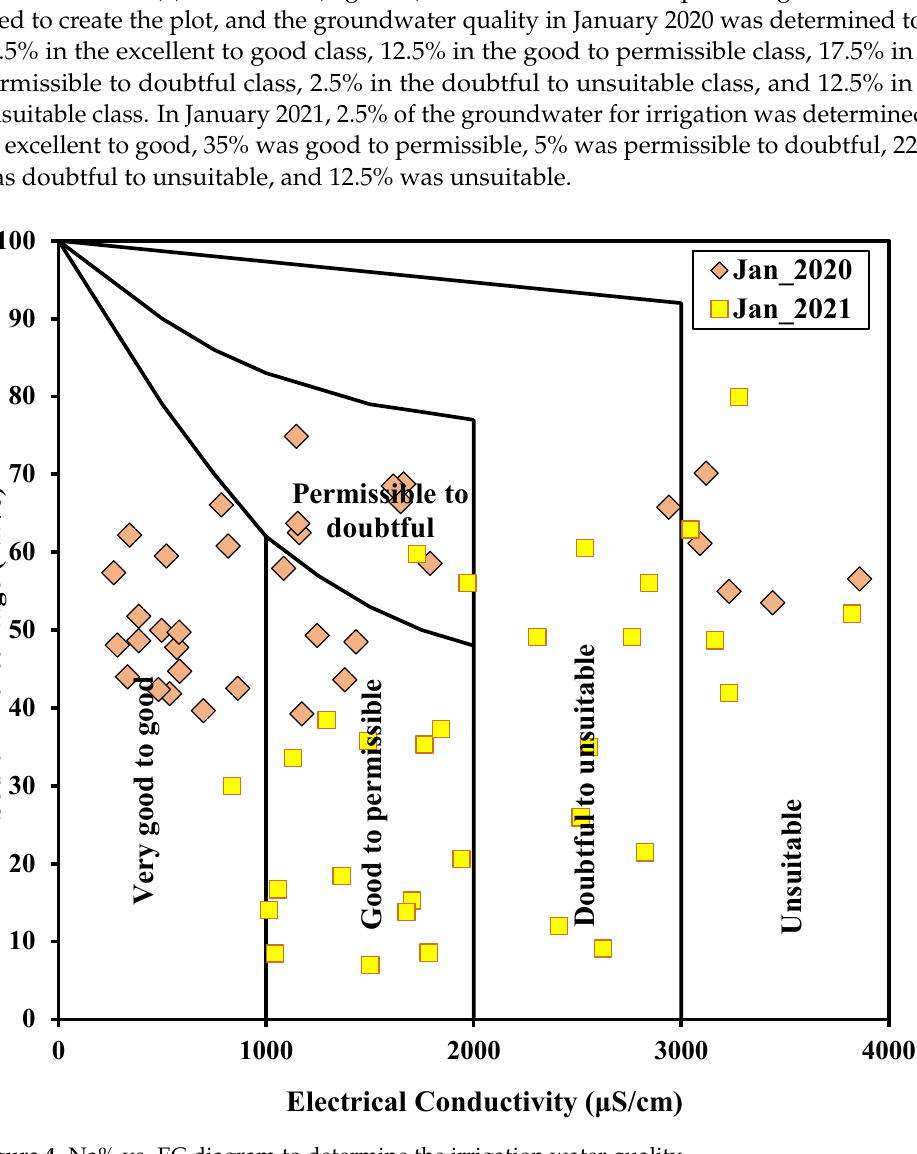
Figure 4. Na% vs. EC diagram to determine the irrigation water quality.